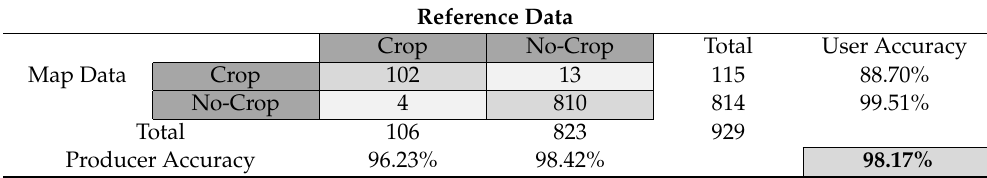
Table 6. The error matrix generated using balanced ground collected reference samples augmented with VHRI interpreted samples.